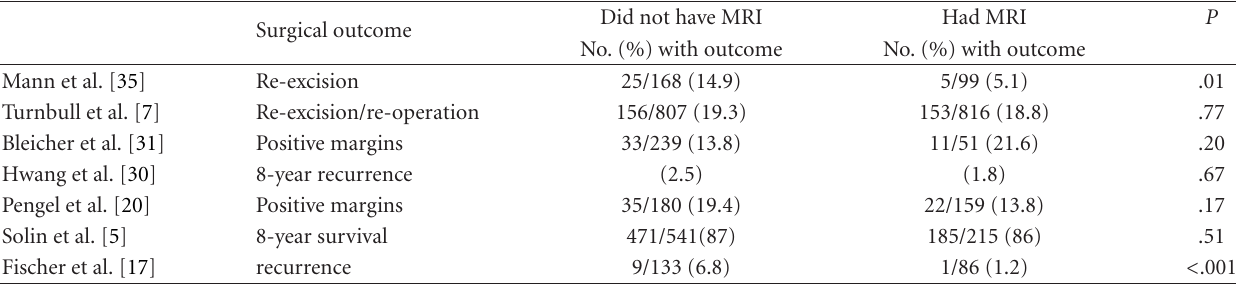
Table 2: Change in Outcome in patients with MRI versus no